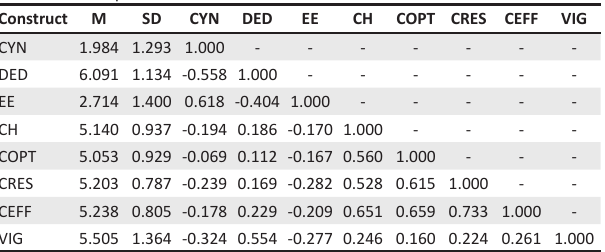
TABLE 4: Descriptive information of constructs. Construct M